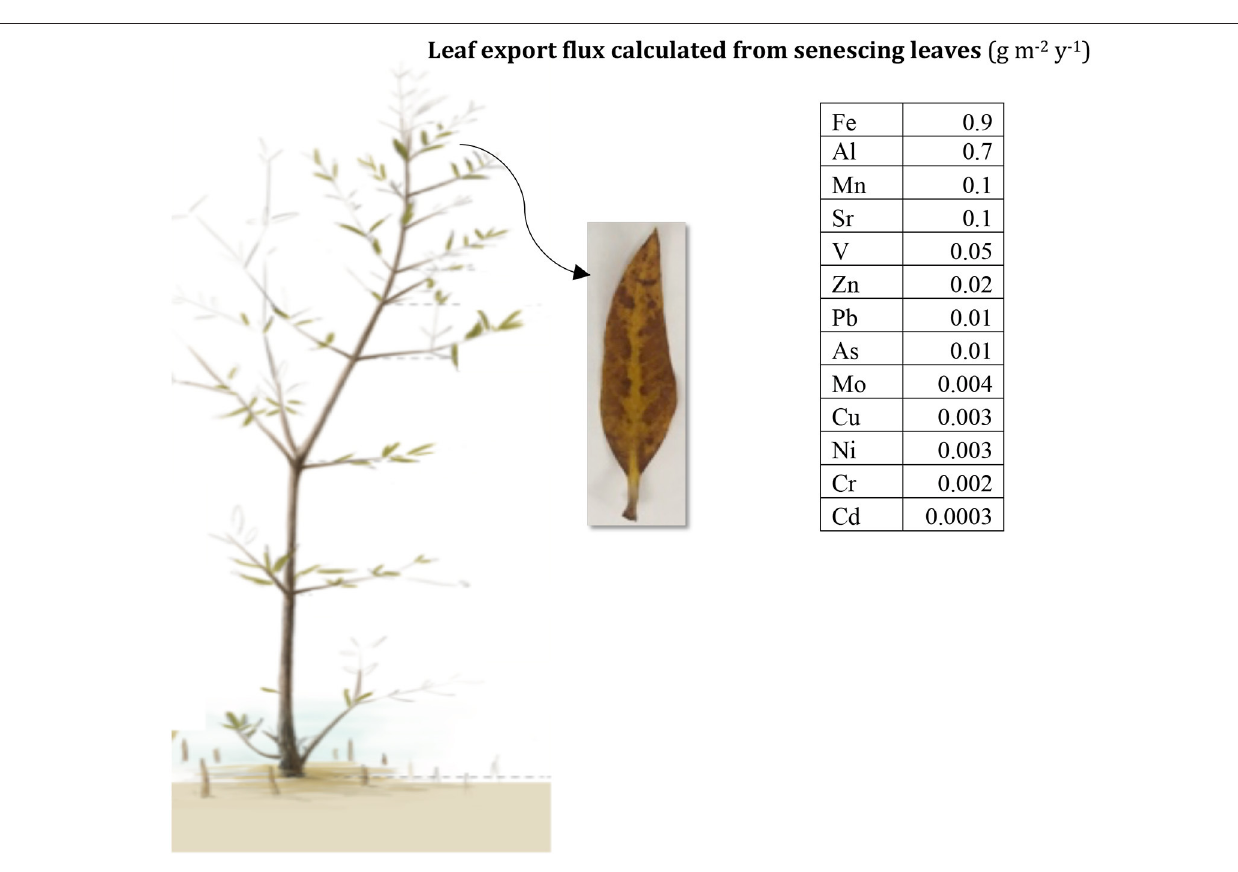
Frontiers in Marine Science | www.frontiersin.org